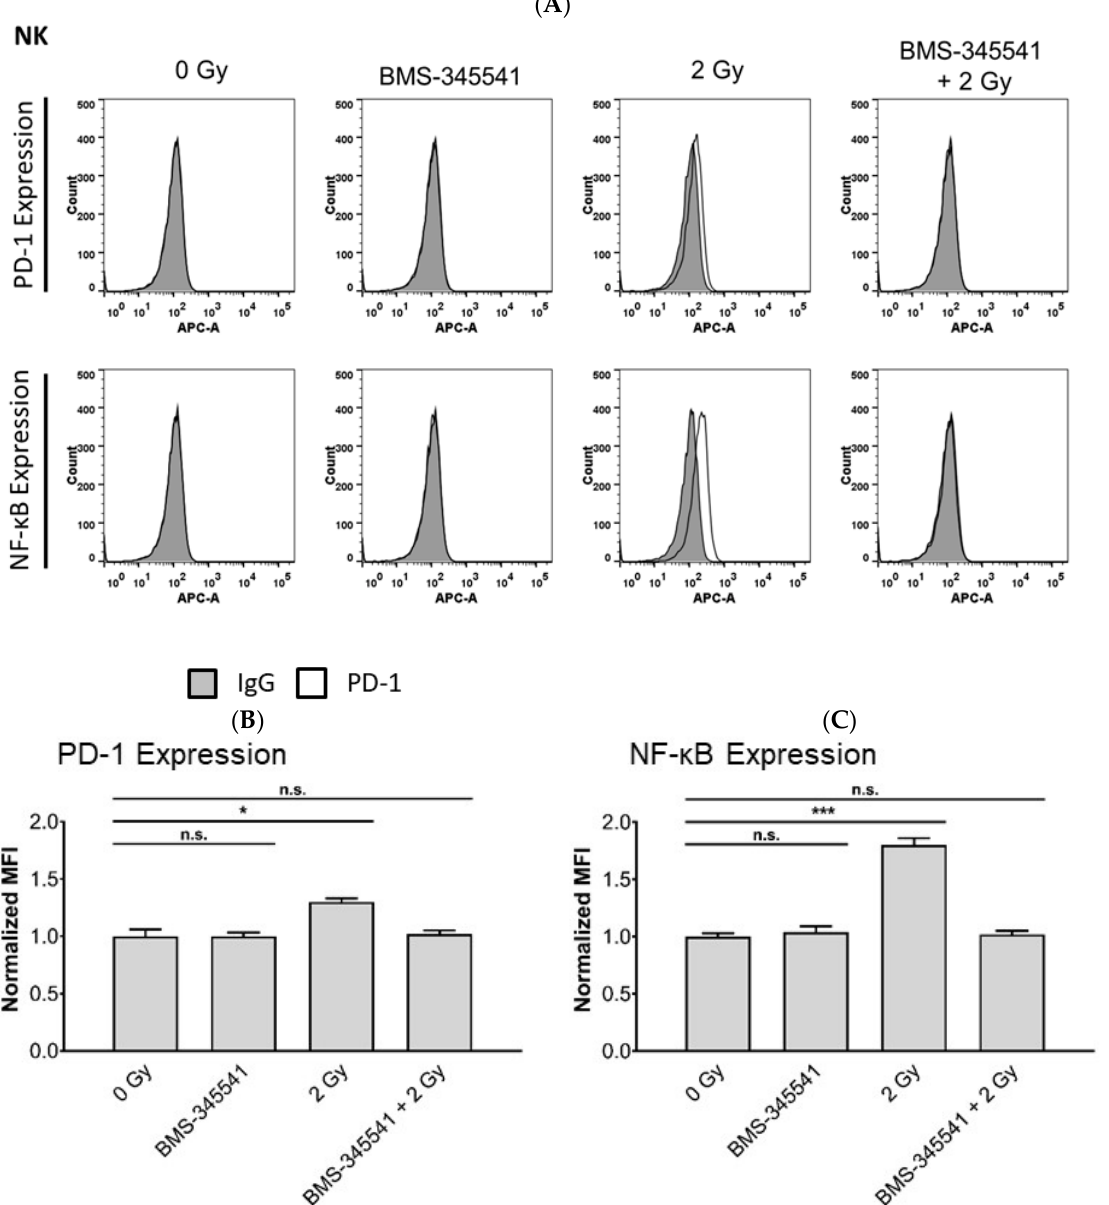
Figure 6. Radiotherapy induces PD-1 expression in NK cells via upregulation of NF- κ B. NK cells were incubated with the NF- κ B inhibitor BMS-345541 for 1 h before radiation. Expression of NF- κ B, PD-L1 and PD-1 was analyzed by flow cytometry. ( A ) Histogram plots of PD-1 and NF- κ B expression on NK cells. Quantification of PD-1 ( B ) NF- κ B ( C ) expression on NK cells. Quantitative data of three independent experiments is shown as normalized mean fluorescence intensity (MFI). Normalized MFI is calculated by dividing the MFI of the sample stained with the antibody of interest by the MFI of the control antibody. Data is shown as mean ± S.E.M. Asterisks indicate statistically significant differences between all cell lines (two-way ANOVA; * p < 0.05; *** p < 0.001).